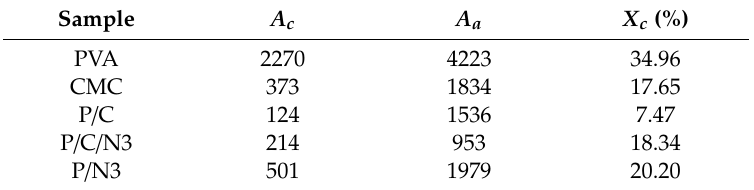
Figure 3. X-ray diffraction (XRD) patterns of Na 2 CO 3 and the obtained composite films. Figure 3. X-ray di ff raction (XRD) patterns of Na 2 CO 3 and the obtained composite films. Table 2. Percentage of crystallinity of the obtained composite Table 2. Percentage of crystallinity of the obtained composite films.